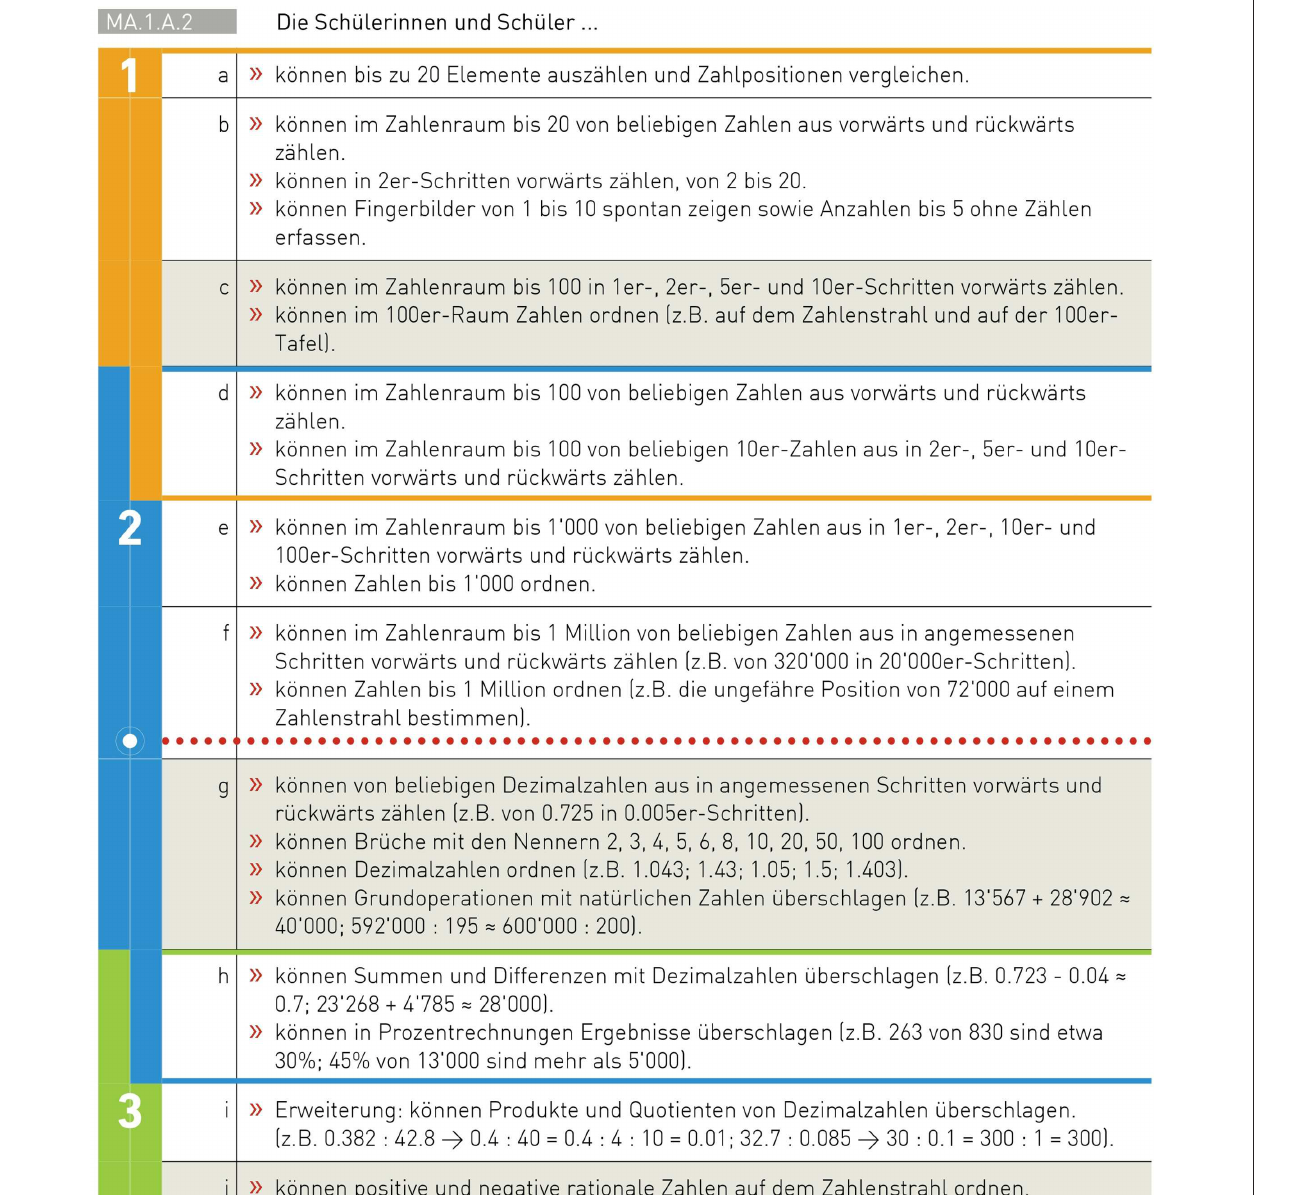
linking items), to link several item blocks. Linking items